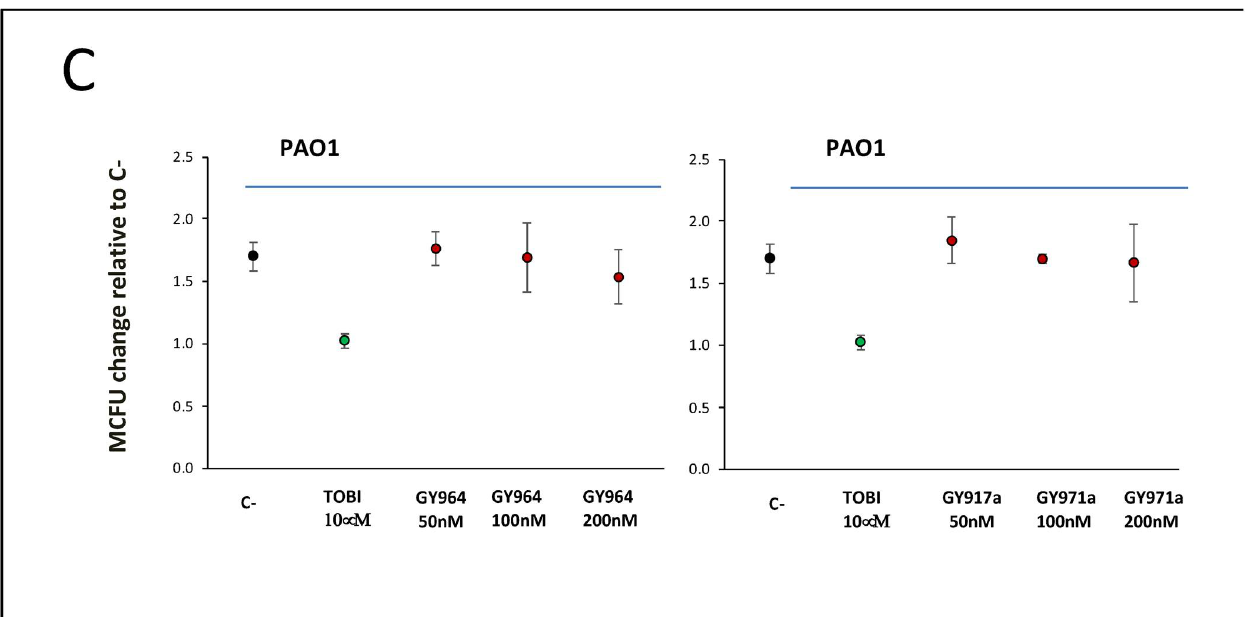
Figure 7. Representative data (apoptosis and cell growth) obtained from the treated IB3-1 (Panel A ) and CFBE41o- (Panel B ) cells: Muse Analyzer plots and cell count recorded 48 h after the treatment with 50, 100, 200 nM TMA, GY964 (4-PhDMA) and GY971a (pANDMA). Antibacterial activity of GY964 (4-PhDMA) and GY971a (pANDMA) (Panel C ) against Pseudomonas aeruginosa (PAO1 strain) after 6 h of incubation (red dots), compared to the untreated strain (black dot) and the strain treated with Tobramycin 10 μM (TOBI) (green dot). C-: untreated cells; vehicle: DMSO.